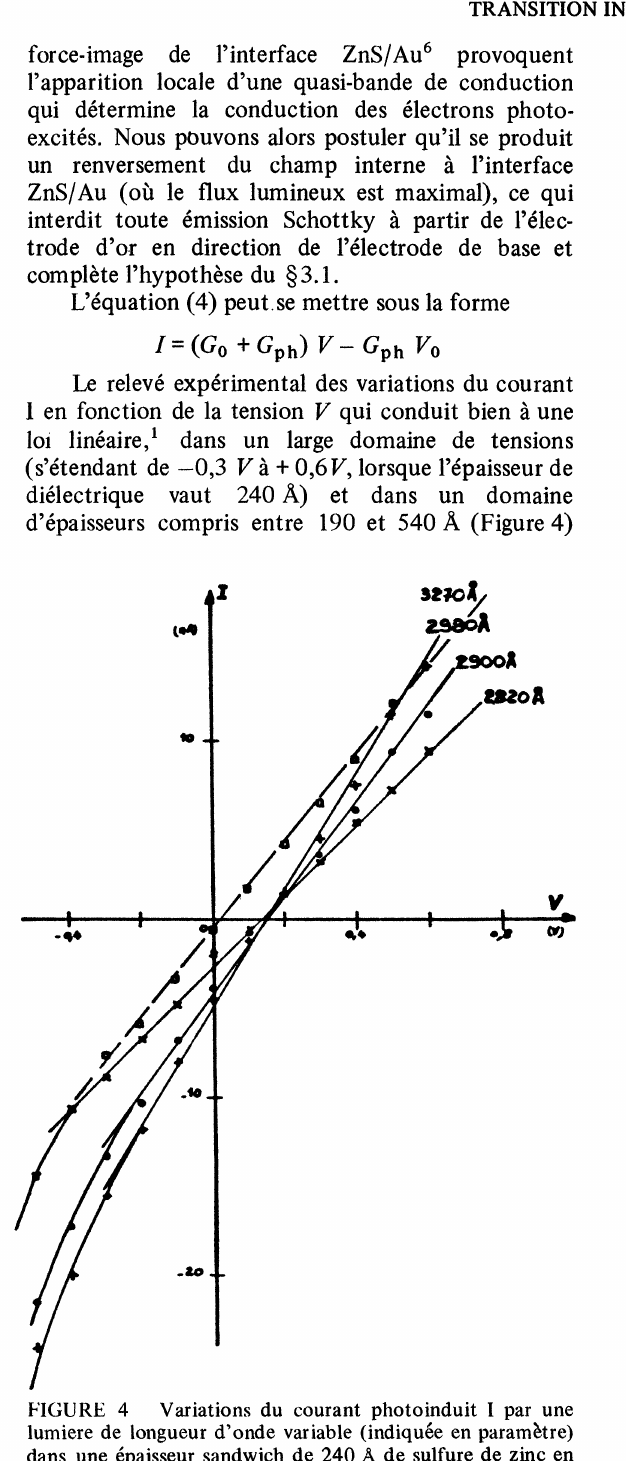
FIGURE 4 Variations du courant photoinduit par une lumiere de longueur d’onde variable (indiqu6e en param[tre) dans une 6paisseur sandwich de 240 A de sulfure de zinc en fonction de la difference de potentiel V applique sur I’lectrode